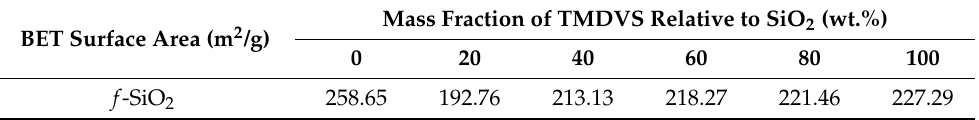
Table 1. The effect of TMDVS content on the BET surface area of f -SiO 2. Mass Fraction of TMDVS Relative to SiO 2 (wt.%) BET Surface Area (m 2 /g)